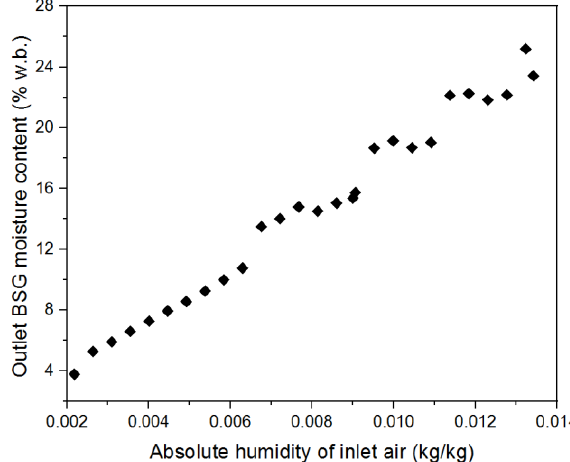
Figure 4. Effect of absolute humidity of the inlet air with a flow rate of 110,262 kg/h on the outlet BSG moisture. Data points presented can be found in the Supplementary Information (Table S3).